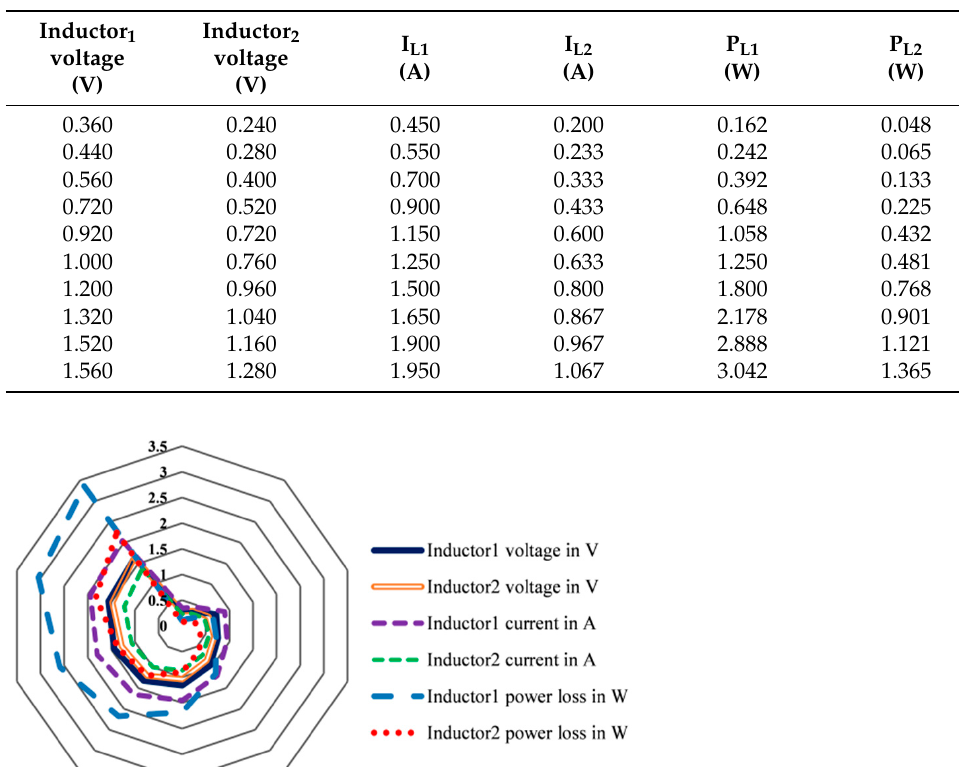
Table 14. Inductor voltage, current and power loss at f s = 10 kHz and D = 50%.